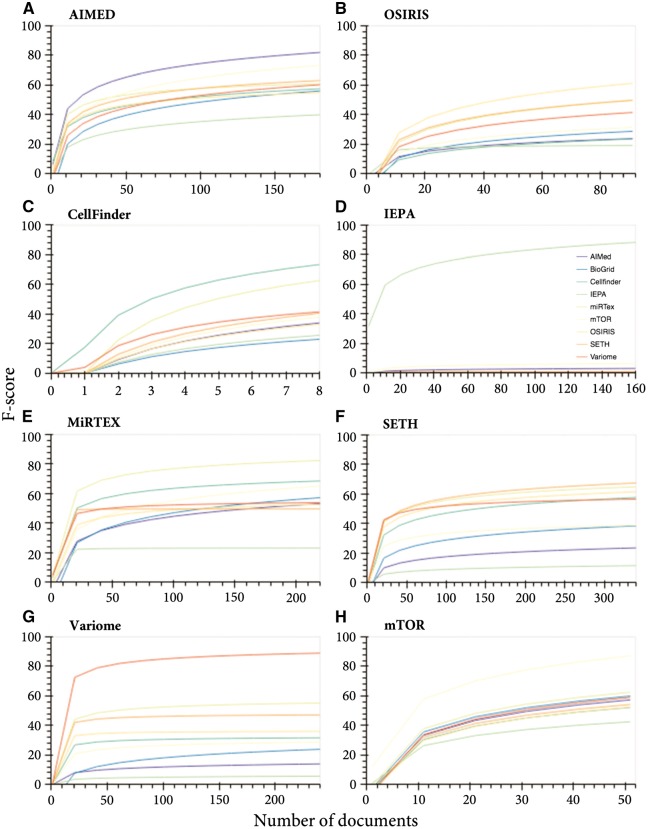
Corpus-specific learning curves for the ‘GeneProtein’ class. Learning curves for corpus-specific training and prediction of all corpora test data. (A) AIMED, (B) OSIRIS, (C) CellFinder, (D) IEPA, (E) MIRTEX, (F) SETH, (G) VariomeCorpus and (H) mTOR